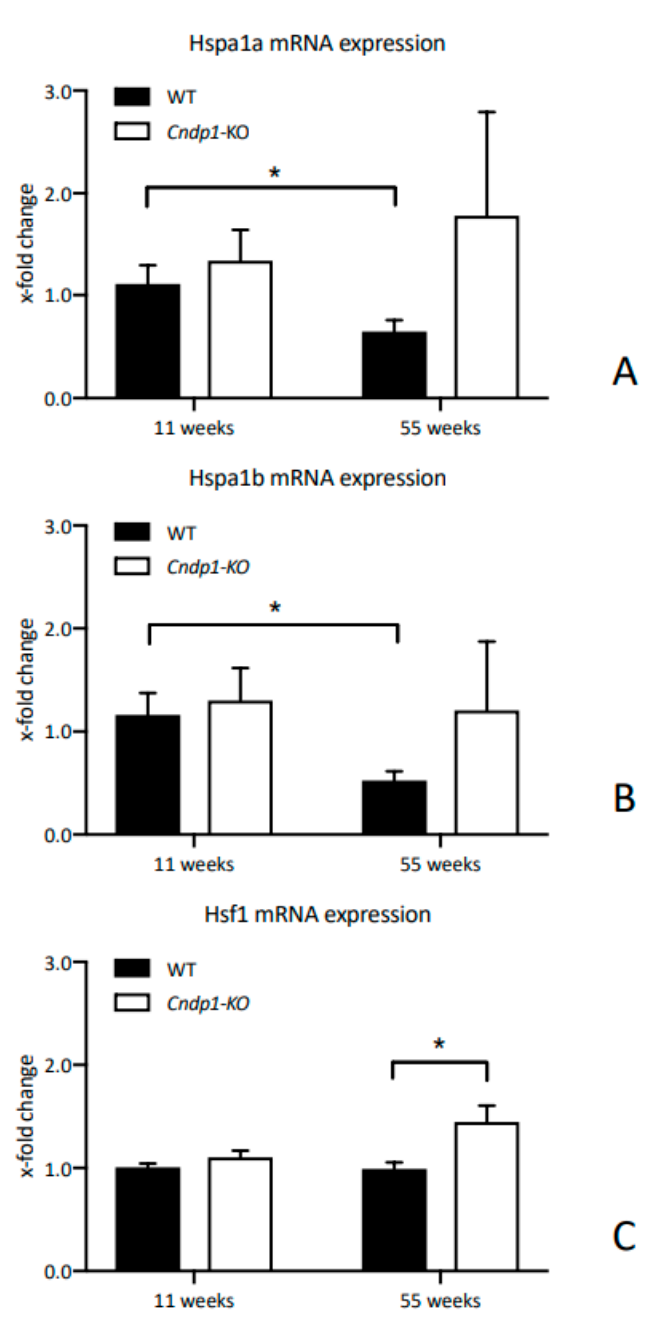
Figure 6. Age-associated reduction of Hspa1a ( A ) andHspa1b ( B ) mRNA expression from week 11 to week 55 in WT but not in Cndp1 -KO mice. Hsf1 ( C ) mRNA expression was higher in Cndp1 -KO at the age 55 weeks compared to WT mice ( n = 10). mRNA expression was normalized to WT mice at the age of 11 weeks. Data are represented as mean ± SEM. *: p < 0.05.